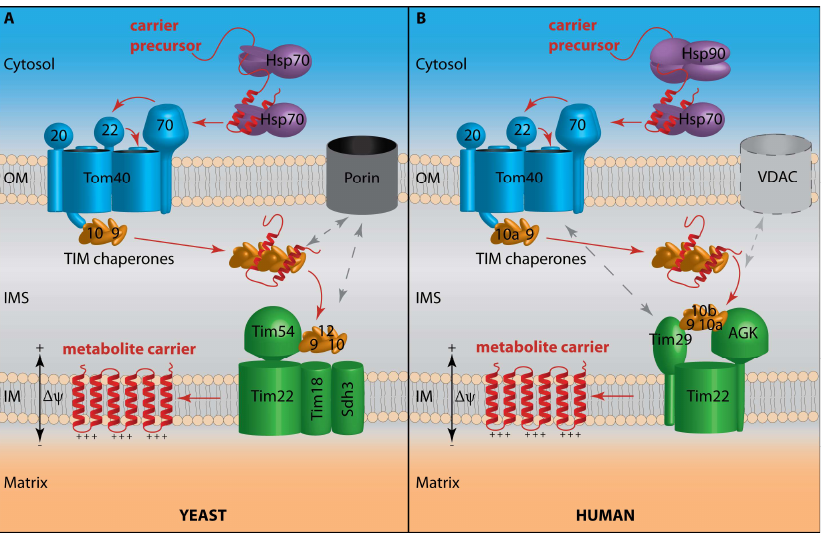
Figure 1. The carrier pathway in the yeast S. cerevisiae ( A ) and in humans ( B ) handles the recognition, translocation and membrane integration of mitochondrial metabolite carriers into the inner membrane. Carrier precursors are bound by chaperones in the cytosol and recognized at the translocase of the outer membrane (TOM) by the Tom70 receptor. After their transfer through the outer